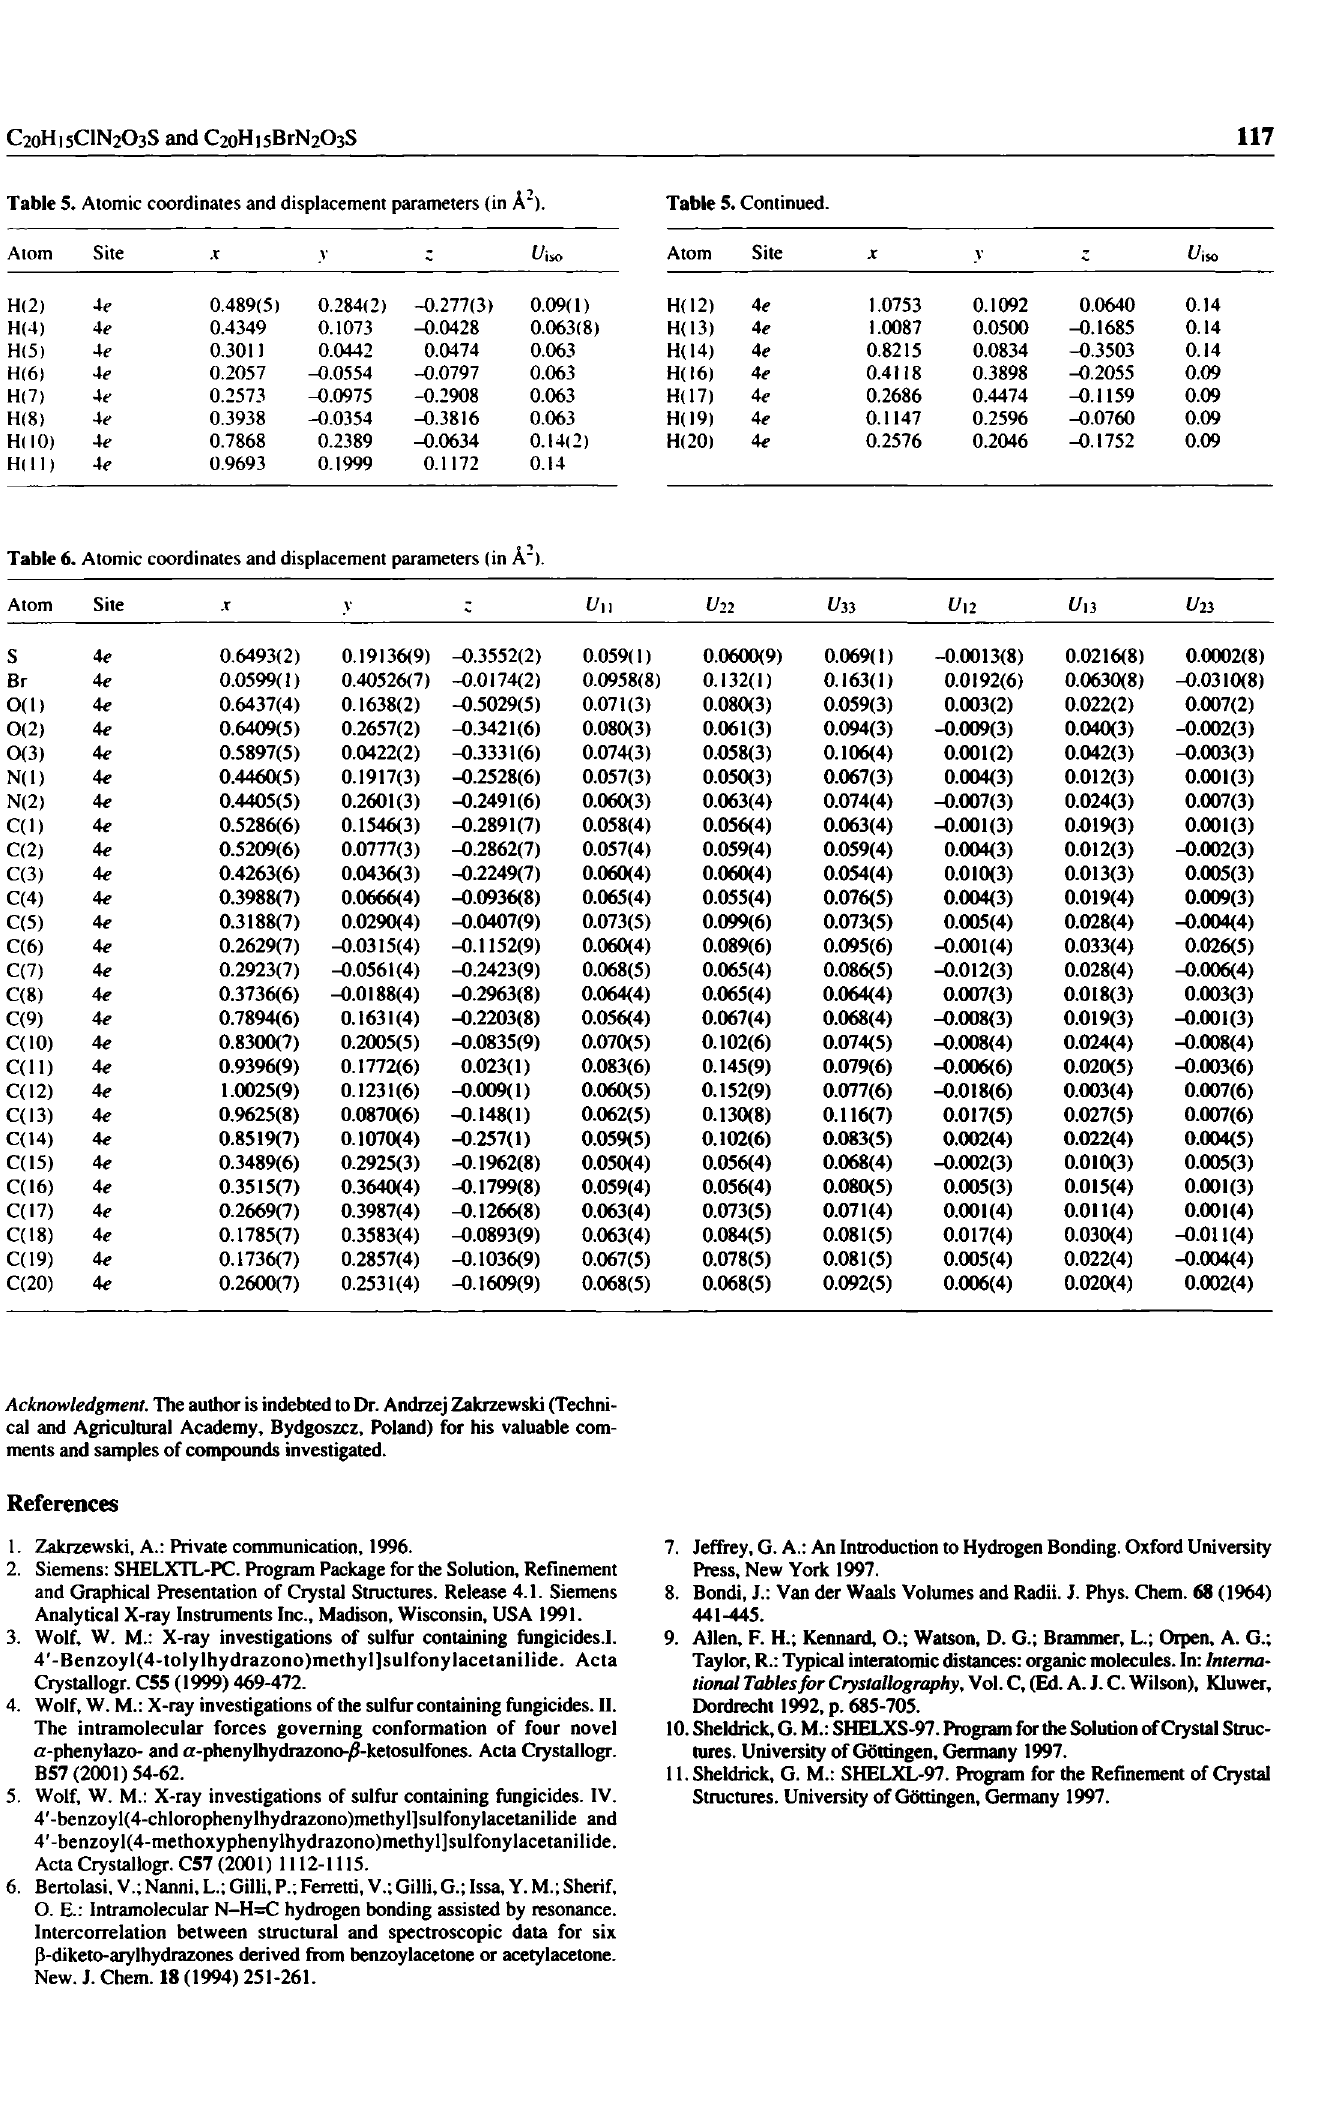
Table 6. Atomic coordinates and displacement parameters (in